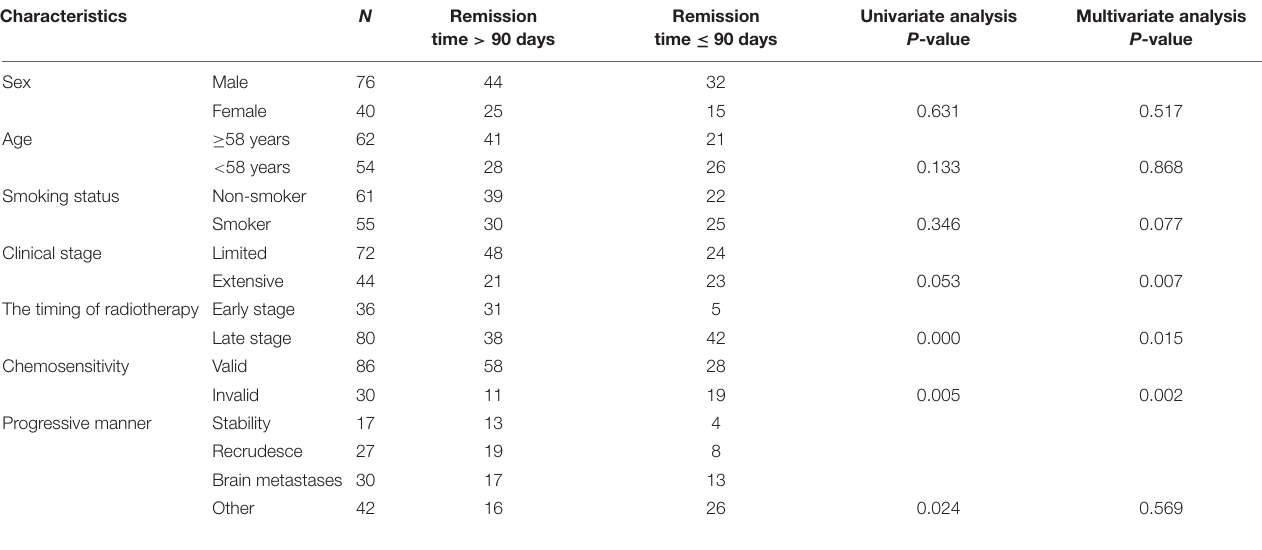
TABLE 1 | Analysis of clinical characteristics and remission time among 116 patients with small cell lung cancer.